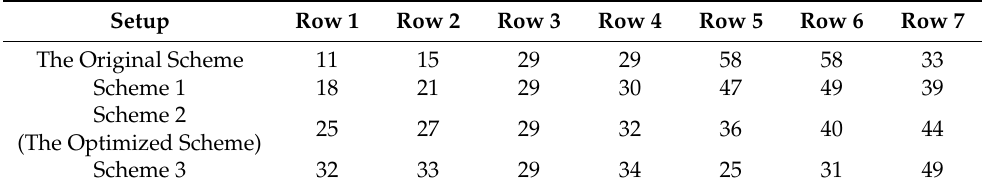
Table 4. Three proposed schemes for fin